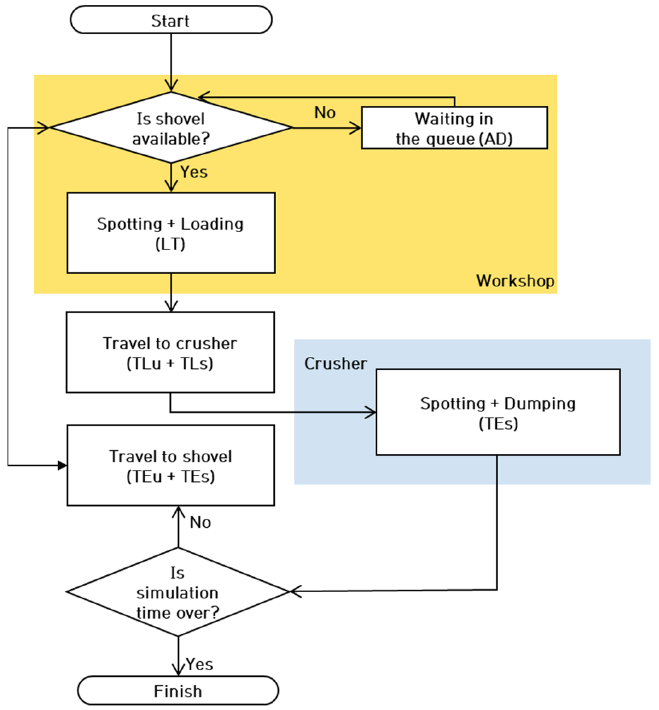
Figure 5. Flow chart displaying procedures for implementing the truck haulage simulation algo- rithm.